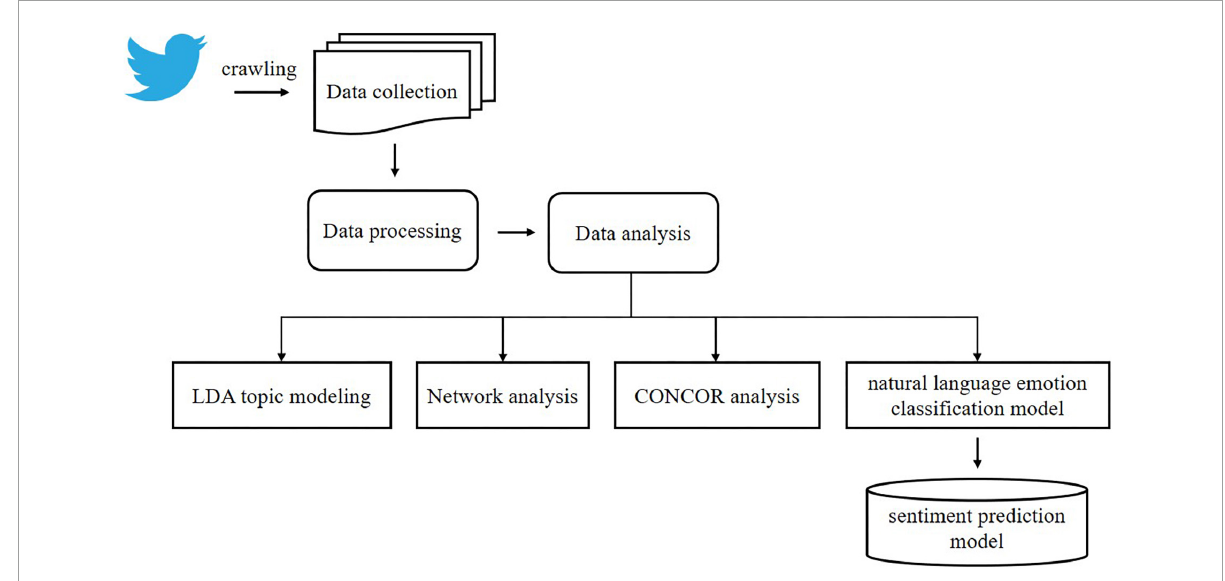
FIGURE2 Schematic diagram of this